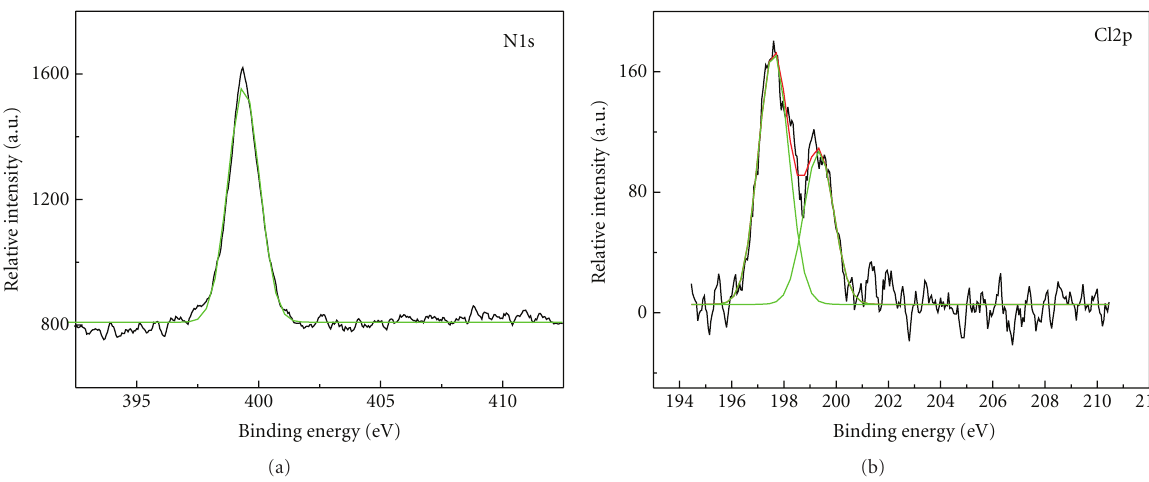
Figure 3: High-resolution XPS spectra of N1 s (a) and Cl2 p (b) for N-Cl-codoped TiO 2 photocatalyst.